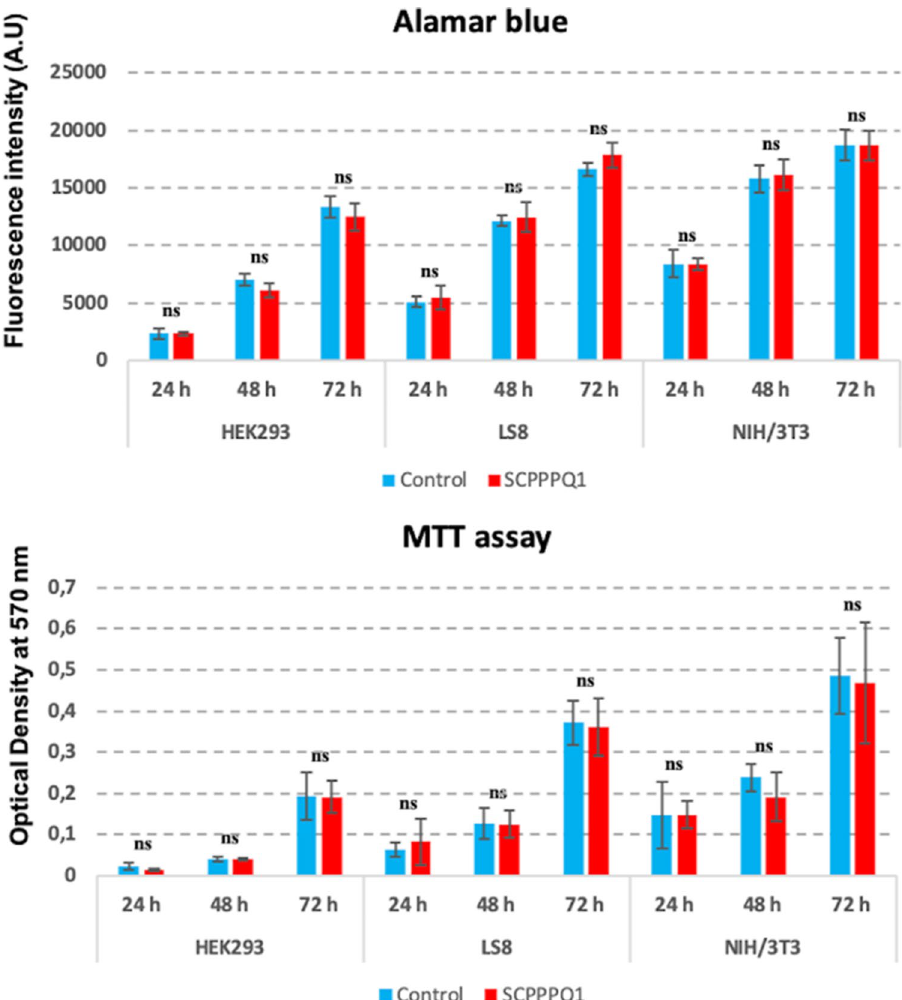
Figure 6. Analysis of the effect of SCPPPQ1 on mammalian cells. HEK293, LS8 and NIH/3T3 cells were incubated with SCPPPQ1 (20 µM) or only the buffer (control) for 72 h. Each 24 h, some cells were processed for both Alamar Blue and MTT assays. The data reveal no significant difference in cell proliferation in the presence or absence of SCPPPQ1. Data represent the means ± SD (n = 3). A.U. arbitrary unit, ns not